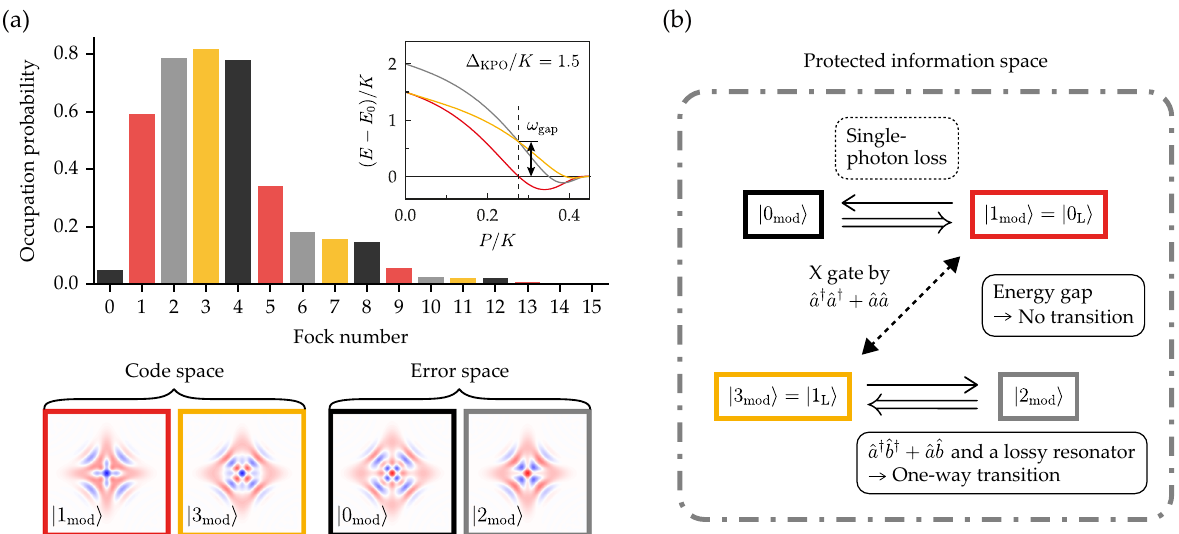
Fig. 1 Information encoding and AQEC scheme in a four-photon KPO. a Four eigenstates in the information space. The upper panel shows the occupation probability of these eigenstates in the Fock basis at Δ KPO / K = 1.5 and P / K = 0.2764 (indicated by a vertical dashed line in the inset), where the energy levels of 0 mod j i and 1 mod j i ( 2 mod j i and 3 mod j i ) are degenerate. Here, E 0 is the energy level of 0 mod j i . The inset shows the quasi-energy levels of the four eigenstates as a function of P . The four lower panels show the Wigner distribution of the four eigenstates. The eigenstates with the odd/even number parity consist of the code/error space. b Requirements for AQEC. The dash-dot line forming the gray boundary represents protection of the information space provided by the four-photon pump. Double arrows ( ⇒ ) indicate induced transitions, and single arrows ( → ) indicate spontaneous transitions caused by single-photon loss. Colors of bars and frames in this fi gure indicate the modulus of 4 in the Fock